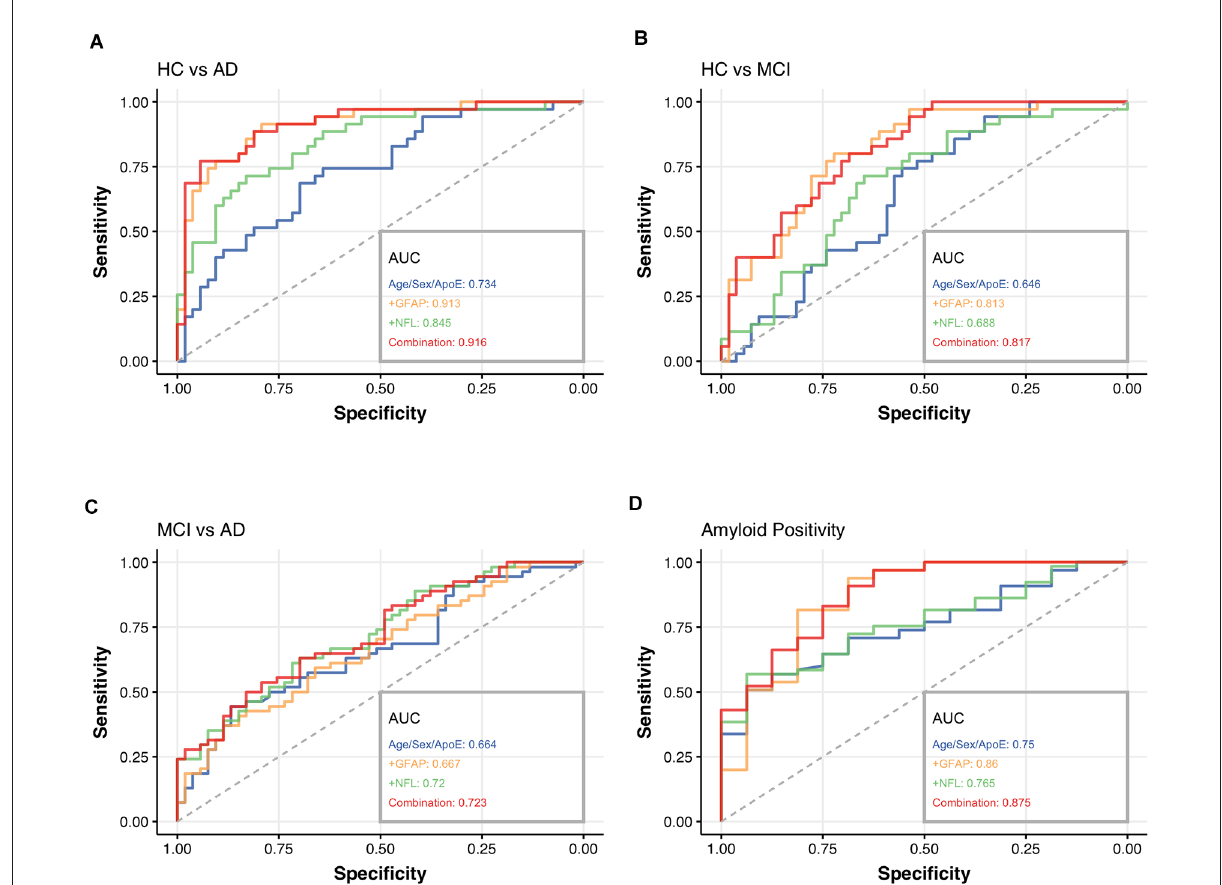
FIGURE3 Receiver operating characteristic (ROC) curves for the diagnostic performance in distinguishing HC from AD (A) , HC from MCI (B) , MCI from AD (C) , the differentiation between amyloid positive and negative patients in our cohort (D) . The area under the curve (AUC) of each model was compared using DeLong’s test for correlated AUC curves. The four panels analyzed were called age+sex+ APOE4 (blue), GFAP+ (age+sex+ APOE4 +GFAP, orange), NfL+ (age+sex+ APOE4 +NfL, green), and Combination panel (age+sex+ APOE4 +GFAF+NfL, red) in this figure. HC , healthy controls; MCI , mild cognitive impairment; AD , Alzheimer’s disease; NfL , neurofilament light chain; GFAP , glial fibrillary acidic protein; AUC , area under the